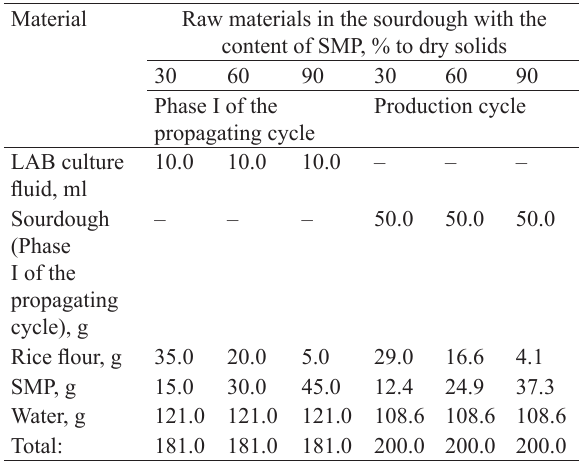
Table 1 Formulae for sourdough with SMP and pure LAB cultures in the propagating and production cycles Material Raw materials in the sourdough with